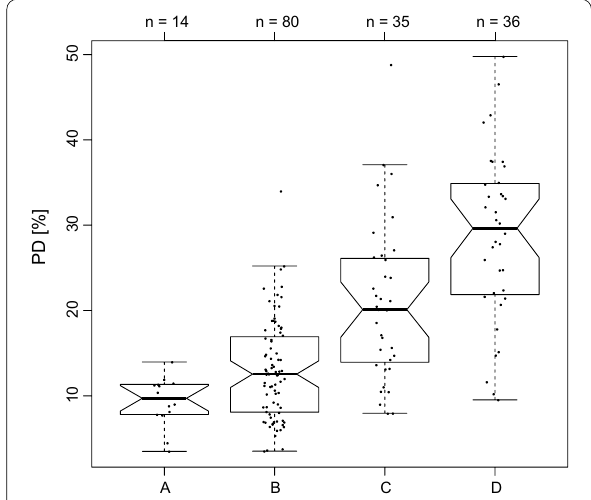
Fig. 5 Percent density association with BI-RADS assigned by radiologists. Each point is a